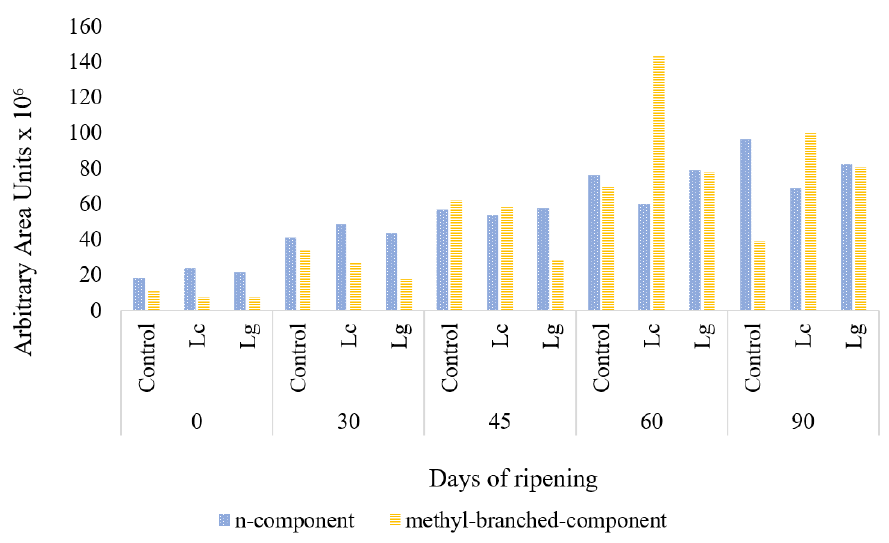
Figure 2. Accumulated area (AU × 10 6 ) of n-compounds and methyl branched compounds through- out the ripening of “Torta del Casar” cheese in Control, inoculated with Lacticaseibacillus casei (Lc) and inoculated with Lactococcus garvieae (Lg) batches.